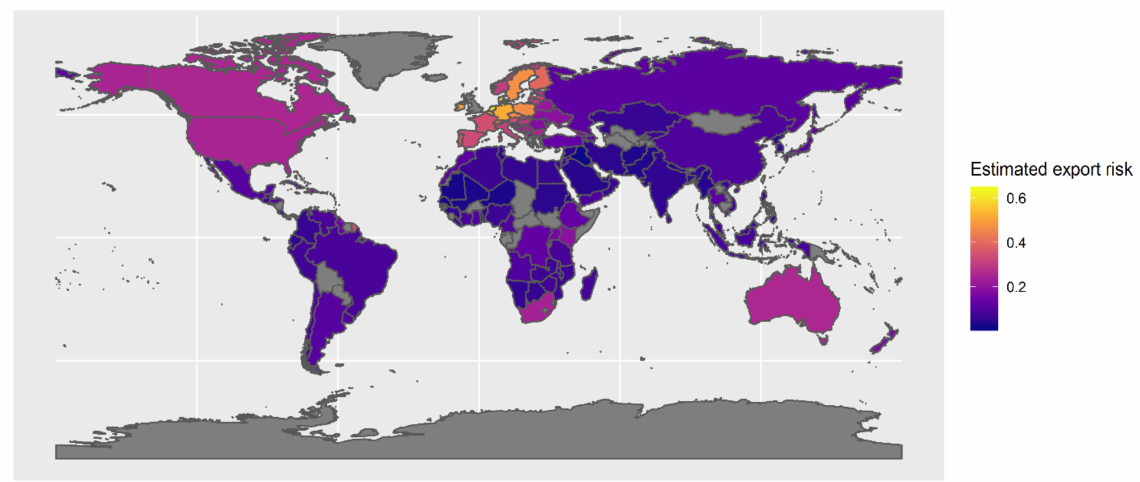
Figure 9. Estimated risk of export of a new Phytophthora to the UK by exporting country, based on trade flows, climate- similarity, reported Phytophthora richness, plant health reporting activity and national biosecurity